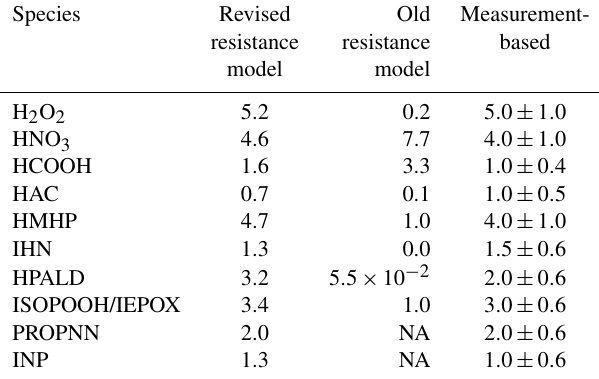
Table 2. Estimates of the dry deposition velocities (cms − 1 ) to the canopy foliage for relevant molecules at 12:00 local time. The measurement-based deposition velocities for a temperate forest are provided as a reference (Nguyen et al.,